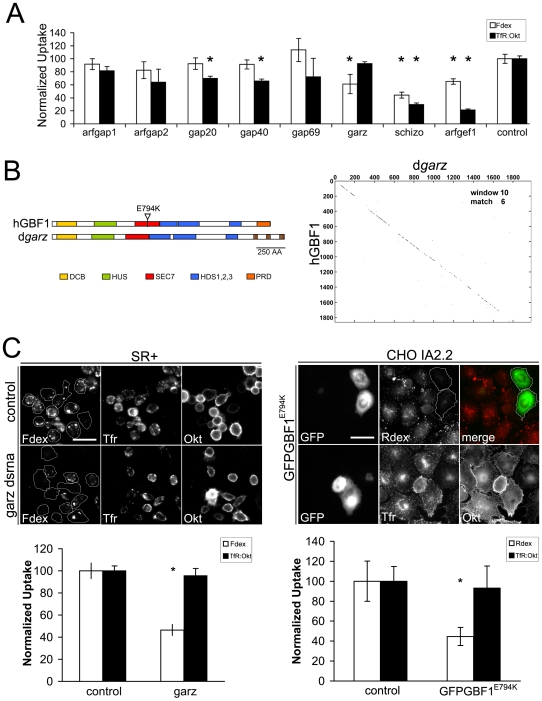
A conserved role for GBF1 in fluid phase uptake in Drosophila and mammalian cells.(A) Normalized uptake of Fdex and TfR was measured as before in S2R+ cells treated with dsRNAs corresponding to various predicted Arf GAPs and GEFs from the Drosophila genome (corresponding CG numbers are: arfgap1 CG6838; arfgap2 CG16728; gap20 CG4937; gap40 CG8243; gap69 CG4237; garz CG8487; schizo CG32434; arfgef1 CG7578). Notably depletion of the Arf GEF garz was singled out because it affected Fdex but not Tf internalization, while other other depletions either had no major effect or affected both pathways significantly. Values are represented as mean±s.e.m. derived from 2 independent experiments with n>200 cells in each condition. Asterix denote P<0.05 by Student's t-test. (B) Cartoon representation of domain structures in human GBF1 (hGBF1)and Drosophila garz (dgarz) proteins. The glutamic acid to lysine substitution mutation within the catalytic Sec7 domain is marked as E794K. A dot plot comparison of hGBF1 and dgarz primary sequences shows broad conservation throughout the length of the proteins, when a stringent moving window of 6 matches every 10 amino acids is applied. (C) Quantitative uptake of Fdex and TfR in S2R+ cells depleted of garz (left panel) or CHO cells overexpressing non-functional GBF1 (GFPGBF1E794K right panel). In the left panel, representative images of S2R+ cells (outlined) treated with control or garz dsRNA are shown in 3 channels, depicting uptake/binding with Fdex, TfR and Okt respectively. The bar graph below the panel shows the quantitation of Fdex and TfR uptake normalized to control values. Values are represented as mean±s.e.m. derived from 2 independent experiments with n>200 cells in each condition. Asterix denote P<0.05 by Student's t-test. In the right panel, representative images of CHO cells pulsed with Rdex or TfR and overexpressing GFPGBF1E794K (transfected cells are visible in the GFP channel) are shown. Bars in C = 20 µm.